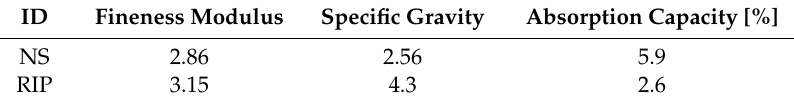
Figure 1. The recycled iron powder used as a fine aggregate ( a ) and the SEM images of recycled iron powder ( b – c ). Table 1. Physical properties of fine aggregates.